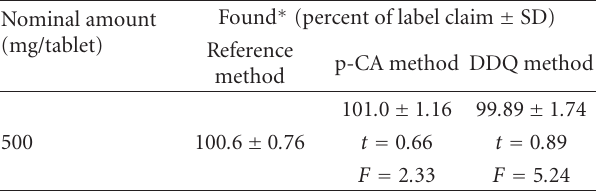
Mean value of 5 determinations. Tabulated t -value at the 95% confidence level and for four degrees of freedom is 2.77. Tabulated F -value at the 95% confidence level and for four degrees of freedom is 6.39. Ψ Marketed by Sun